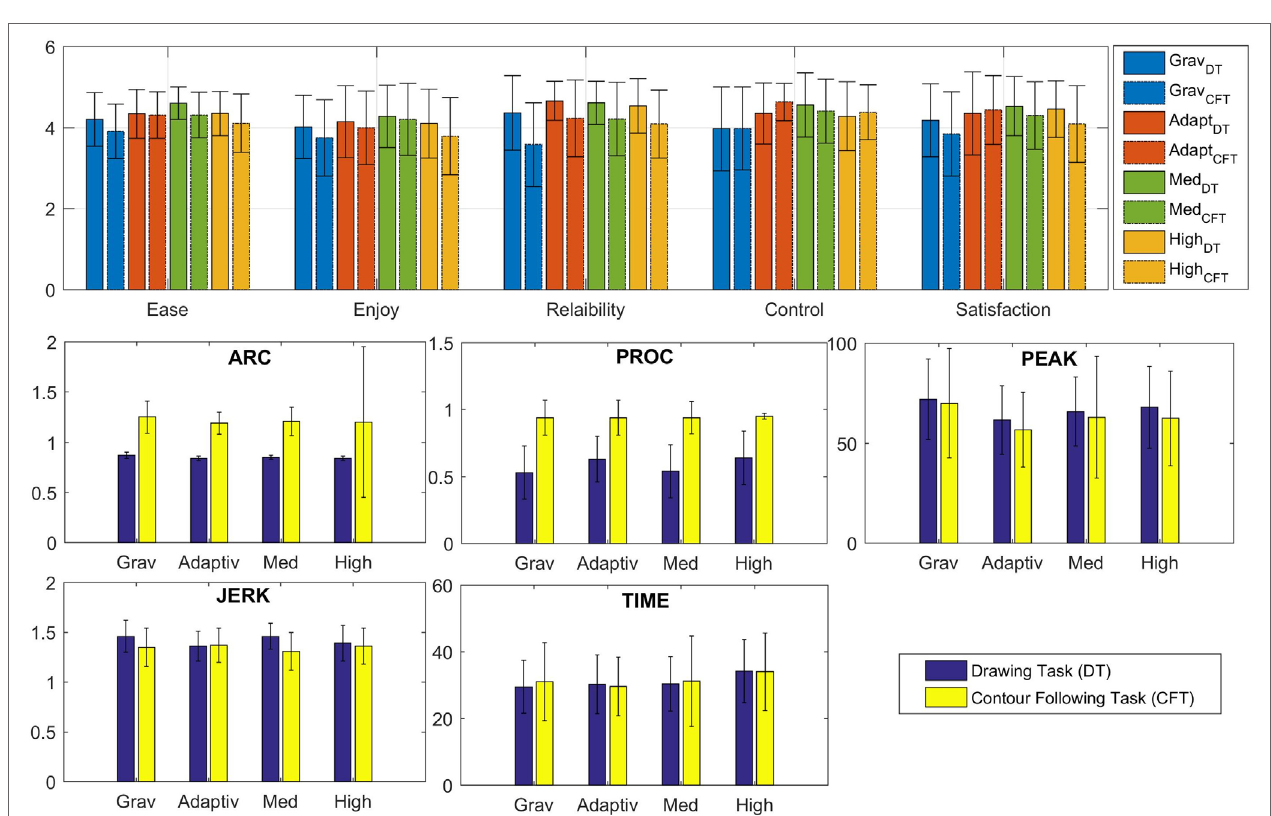
FigUre 5 | Error graphs showing means and SDs of each criteria for the four control modes for contour­following task (C.F.T.) and drawing task (D.T.). The top figure shows the results of the qualitative analysis, and the bottom figures shows the results of the quantitative analysis.